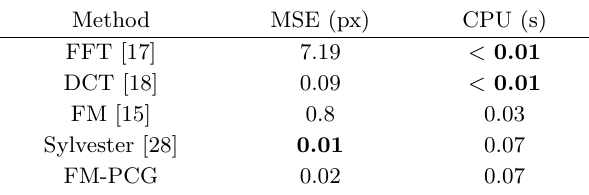
Table 11 Results on the “Peaks” dataset (128 × 128)